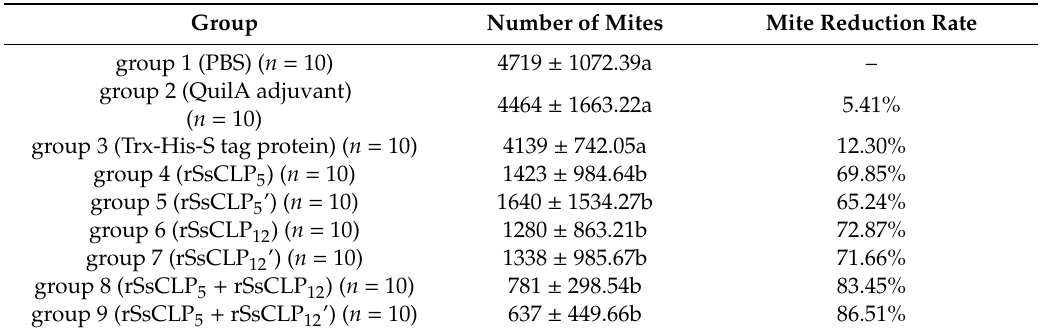
Table 2. Mean mange mite burden at four weeks post-challenge and mite reduction rate of the rabbits. Group Number of Mites Mite Reduction Rate group 1 (PBS) ( n = 10) 4719 ± 1072.39a – group 2 (QuilA adjuvant) 4464 ± 1663.22a 5.41% ( n = 10) group 3 (Trx-His-S tag protein) ( n = 10) 4139 ± 742.05a 12.30% group 4 (rSsCLP 5 ) ( n = 10) 1423 ± 984.64b 69.85% group 5 (rSsCLP 5 ’) ( n = 10) 1640 ± 1534.27b 65.24% group 6 (rSsCLP 12 ) ( n = 10) 1280 ± 863.21b 72.87% group 7 (rSsCLP 12 ’) ( n = 10) 1338 ± 985.67b 71.66% group 8 (rSsCLP 5 + rSsCLP 12 ) ( n = 10) 781 ± 298.54b 83.45% group 9 (rSsCLP 5 + rSsCLP 12 ’) ( n = 10) 637 ± 449.66b